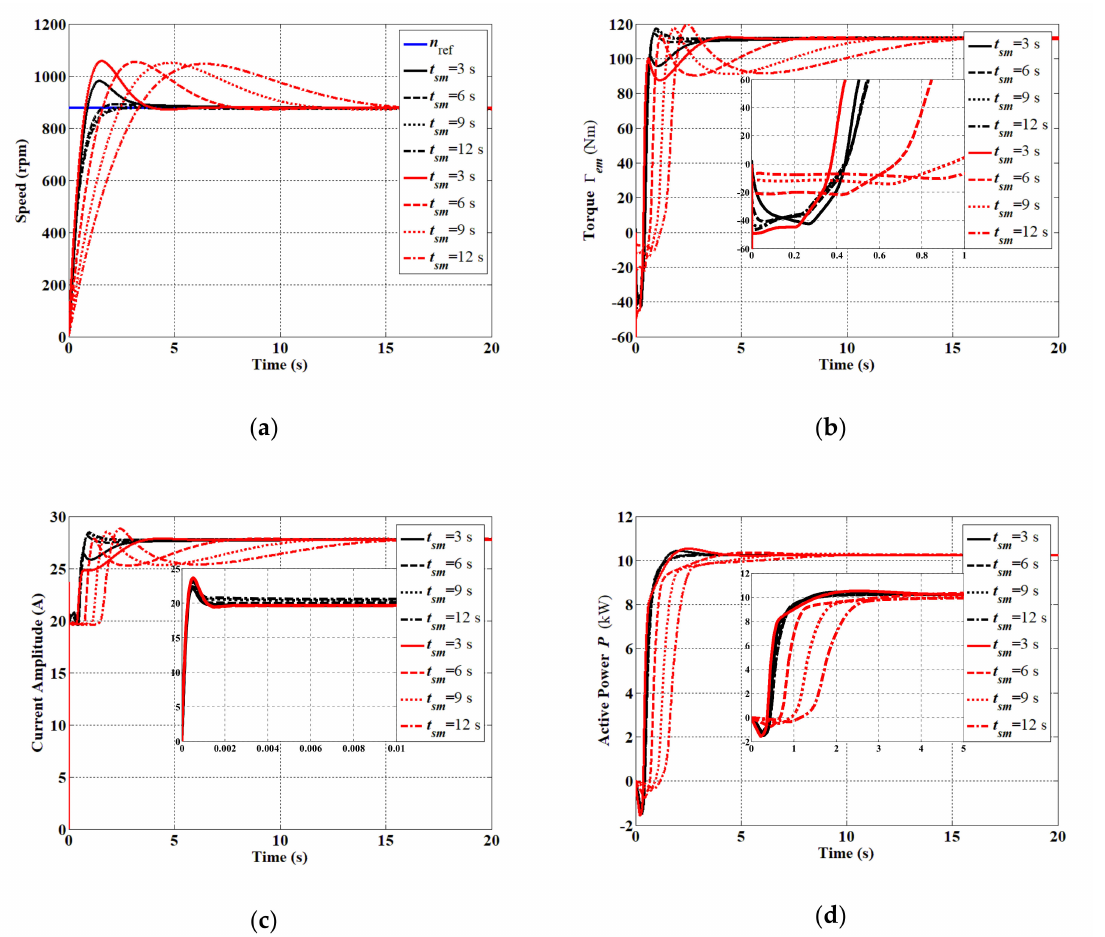
Figure 6. Performance of DFIG for FOPI (black) and IOPI (red) controllers with di ff erent settling time t sm : ( a ) DFIG speed; ( b ) electromagnetic torque; ( c ) rotor current amplitude; ( d ) active